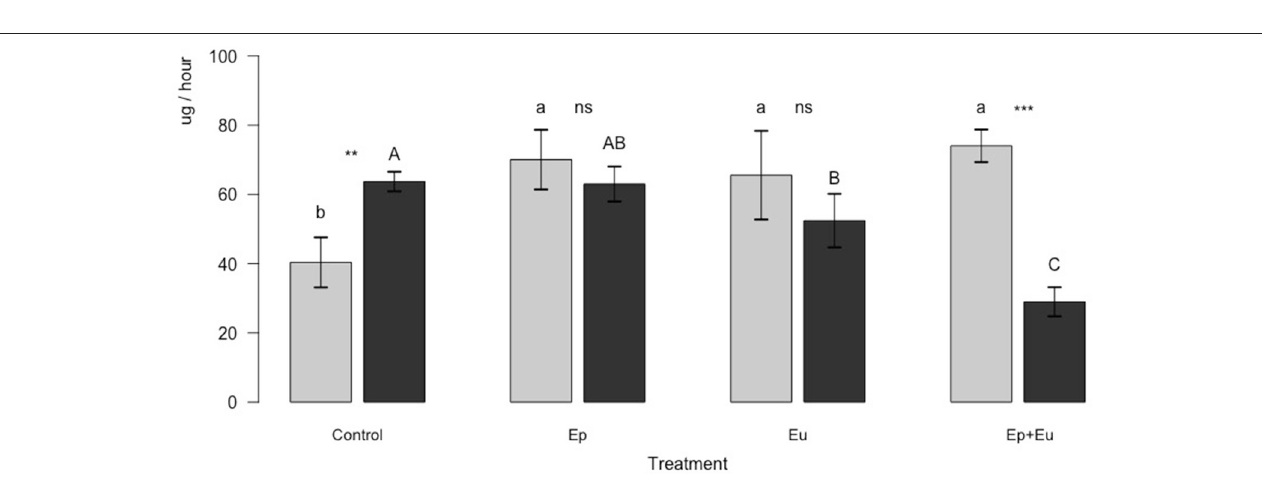
FIGURE 3 | FDA activity (mean ± standard deviation) of four experimental treatments 1 and 2 months after Collembola re-inoculation. Gray bar-plot = first month, black bar-plot = second month. Different minuscule letters (i.e., “a,” “b”) indicate significant differences ( α = 0.05) between treatments for first month; Different capital letters (i.e., “A”, “B”, “C”) indicate significant differences ( α = 0.05) between treatments for second month. The asterisks indicate significant differences between the months for a given treatment (*** p < 0.001, ** p < 0.01, ns p > 0.05). Control, without Collembola; Ep, Epedaphic Collembola; Eu, Euedaphic Collembola; Ep + Eu, mixed functional groups ( n =